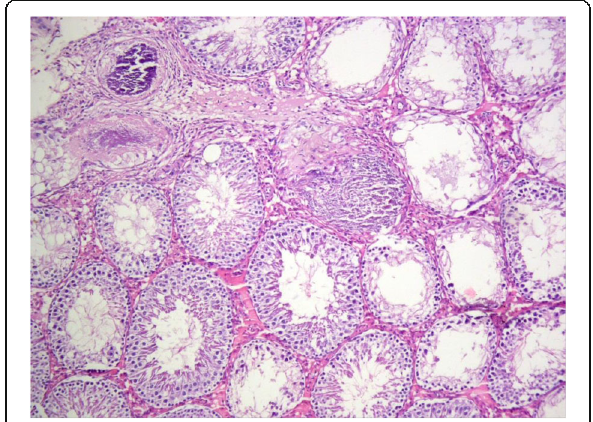
Fig. 3 Testicular section from the tramadol group showing vacuolar degeneration with absent spermatogenesis in some seminiferous tubules. Focal calcification was also regarded (H & E, × 100)